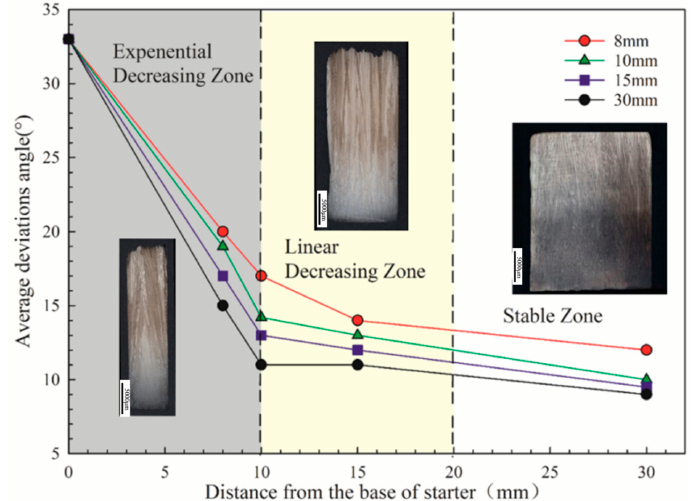
Figure 8. Average deviations between the < 001 > direction of grains and the direction of the heat flux at the top of the starter as a function of width.